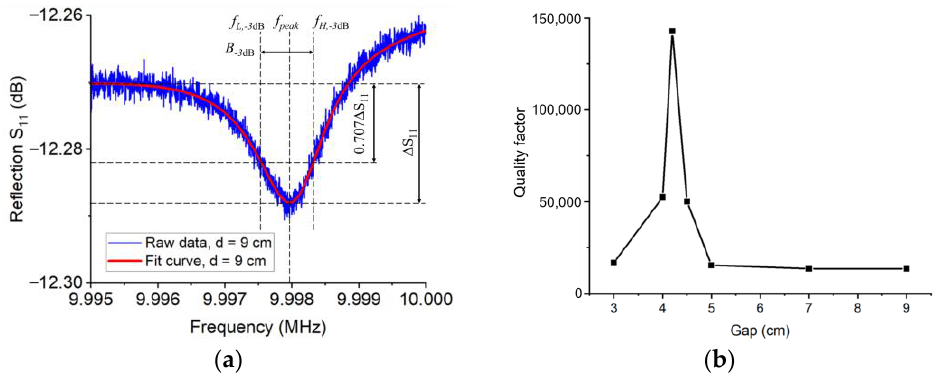
Figure A5. The quality factor of the passive wireless sensor. ( a ) The definition of the quality factor for a BAW passive wireless sensor. ( b ) The quality factor as a function of the gap between coils.